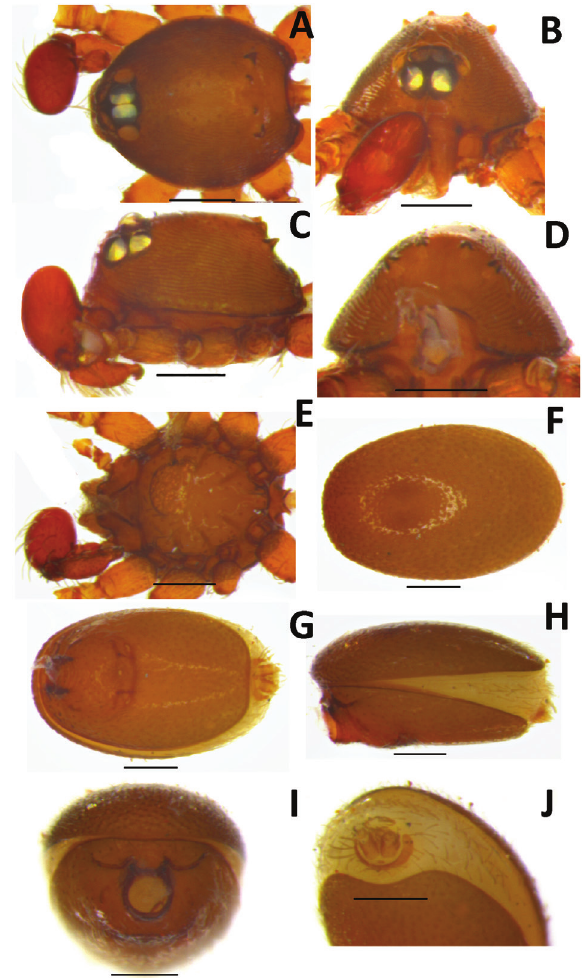
Figure 8. Opopaea spinosiscorona n. sp., male from Kuru- lukelle FR: A , carapace, dorsal view; B , same, anterior view; C , same, lateral view; D , same posterior view; E , sternum, ventral view; F , abdomen, dorsal view; G , same, ventral view; H , same, lateral view; I , same, anterior view; J , same, posterior view. Scale bars: 0.2